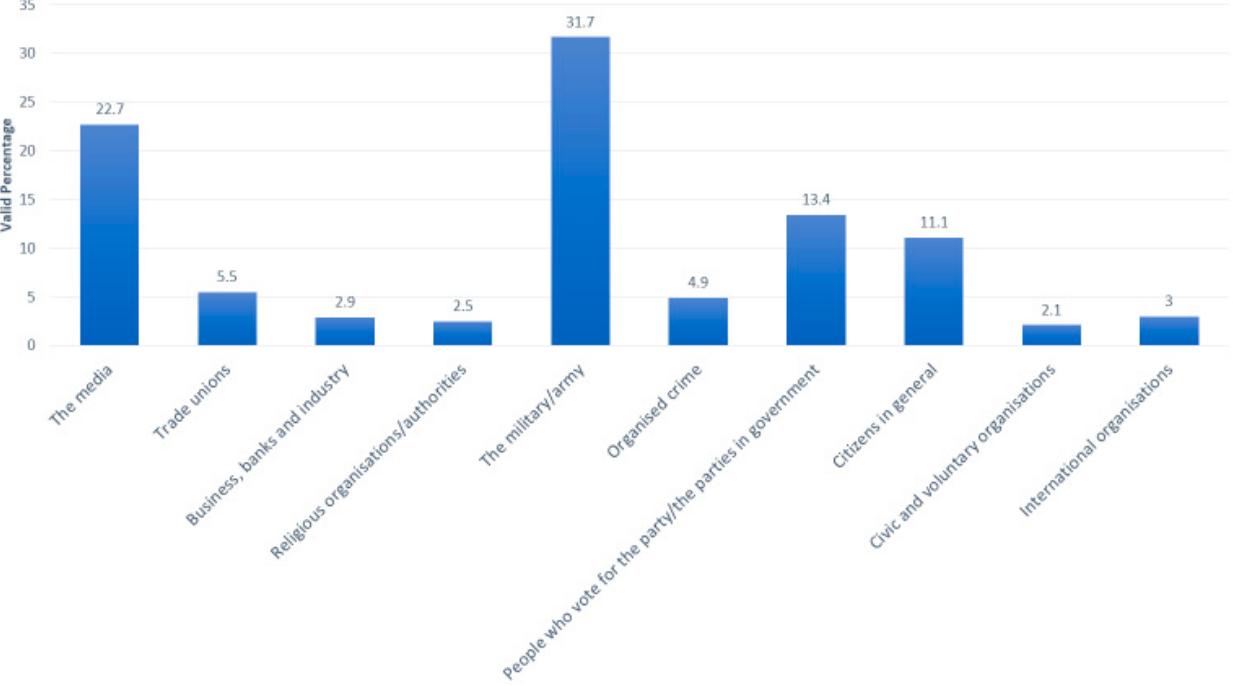
Figure 1. Percentage of responses suggesting that a group had the most influence on the government. Figure 2 illustrates the findings of the second most influential group on the Venezuelan government. The “second most” influential is “the media” ( n = 162, 15.5%) with “the military/army” ( n = 159, 15.2%) close behind, and “people who vote for the party/the parties in government” ( n = 149, 14.3%) in third.